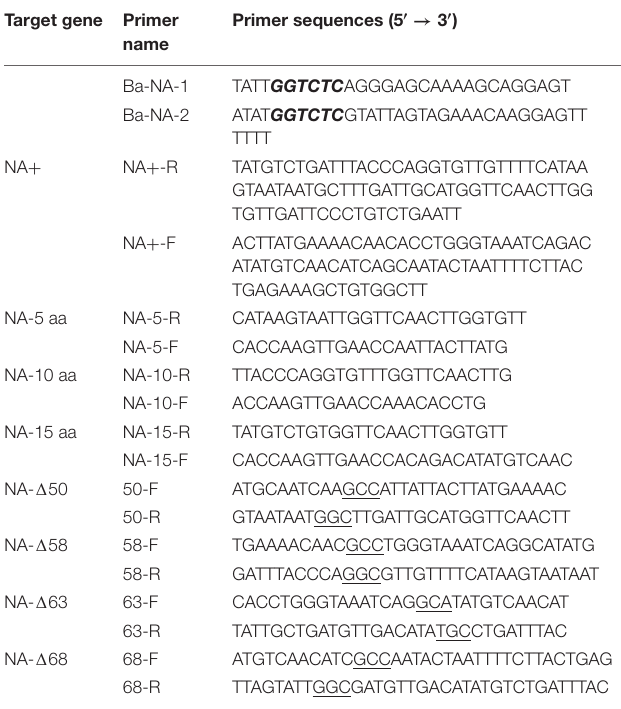
TABLE 1 | Primers for construction of mutant plasmids of NA genes. Target gene Primer